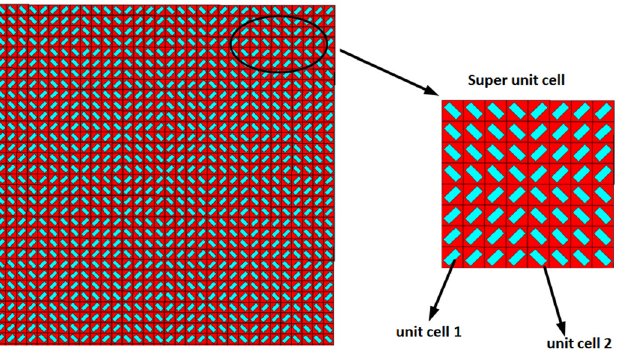
Fig. 7. The arrangement of Metasurface II and structure of its Super unit cell.